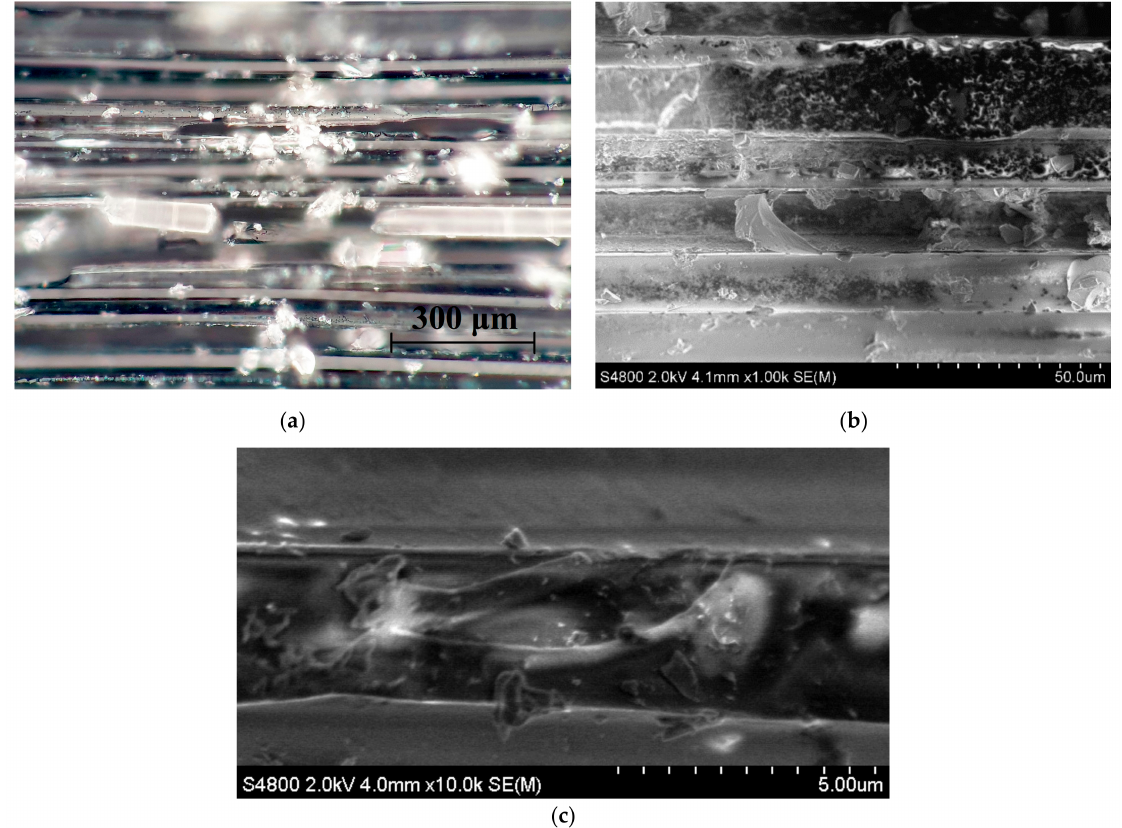
Figure 15. Optical ( a ) and SEM ( b and c ) micrographs of fracture surface of nanomodified epoxy DCB sample after test. Magnifications: 500 × ( a ); 1000 × ( b ); 10,000 × ( c ).